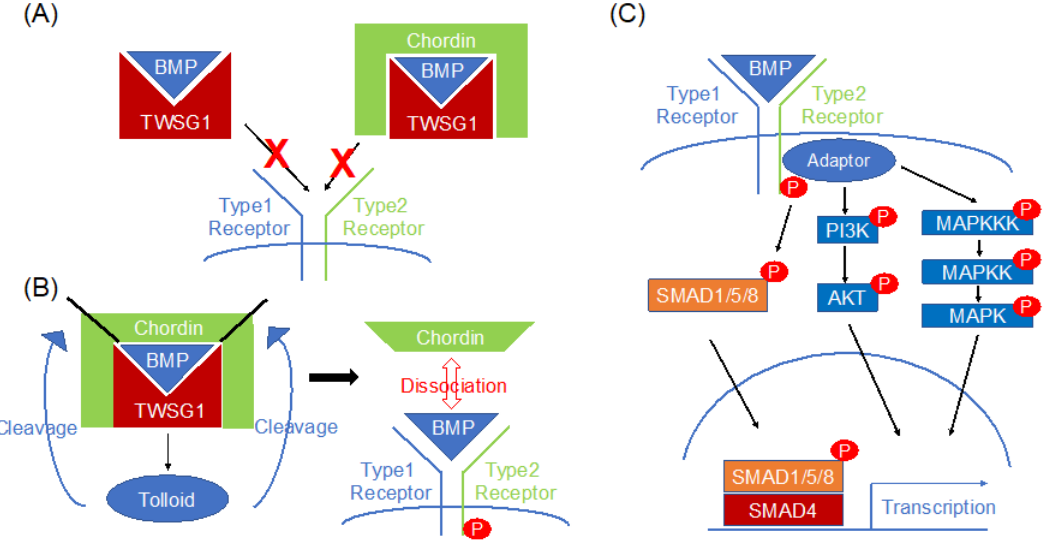
Figure 1. TWSG1 can function as both a BMP agonist and an antagonist. ( A ) TWSG1 functions as a BMP antagonist by inhibiting BMP signaling through BMP ligand binding. TWSG1 also represses BMP signaling through the formation of the BMP – TWSG1 – Chordin ternary complex. ( B ) TWSG1 also functions as a BMP agonist. TWSG1 triggers BMP/Chordin dissociation via the tolloid-dependent cleavage of Chordin. ( C ) Overview of BMP signaling. After activating the receptors, phosphorylated SMAD1/5/8 translocate to the nucleus with SMAD4, leading to transcriptional activation. BMPs can also activate non-SMAD pathways, including PI3K/AKT and MAPK pathways.